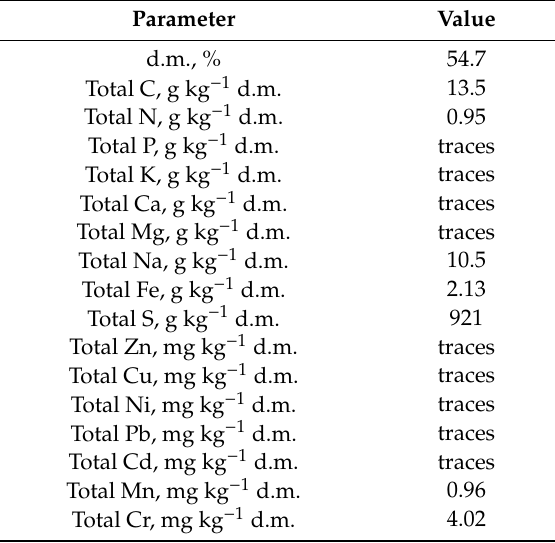
Table 3. Selected chemical properties of sulfur pulp used in the